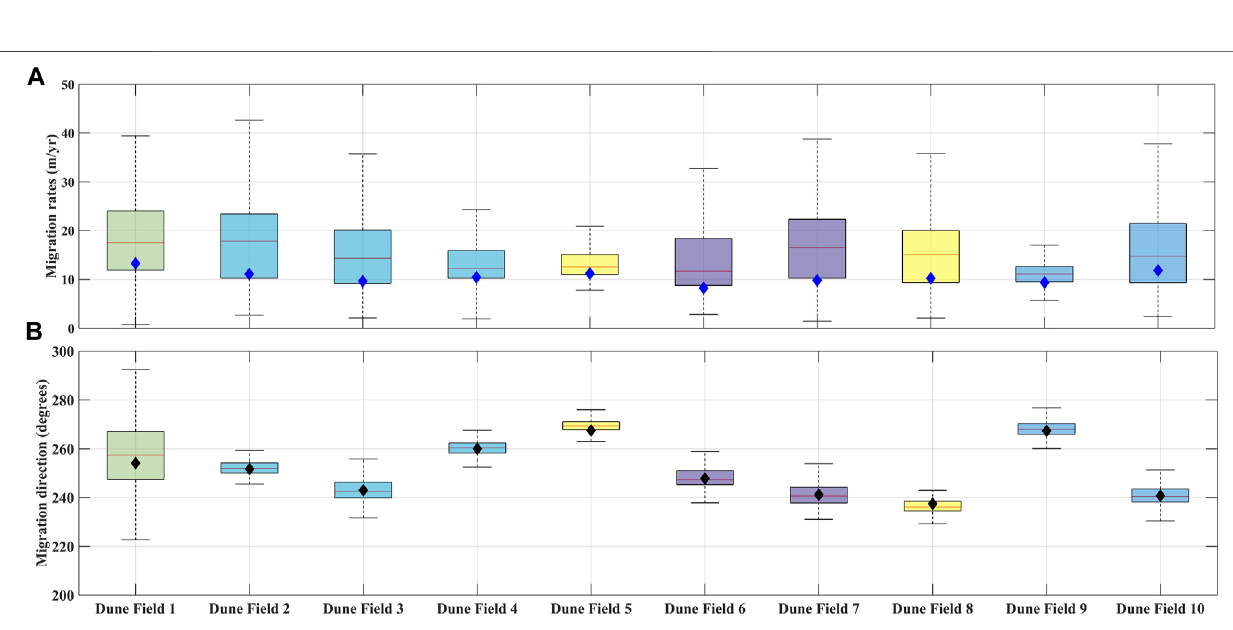
FIGURE 9 | Spatiotemporal variability of the dune migration rates (A) , and directions (B) . Box plots represent the variability of geometric means of dune velocities and the average migration direction of the active aeolian features belonging to each dune fi eld for all the pairs. The blue and black diamonds in (A,B) , respectively, represent the geometric means estimated for the active aeolian features belonging to the AAM and PMD